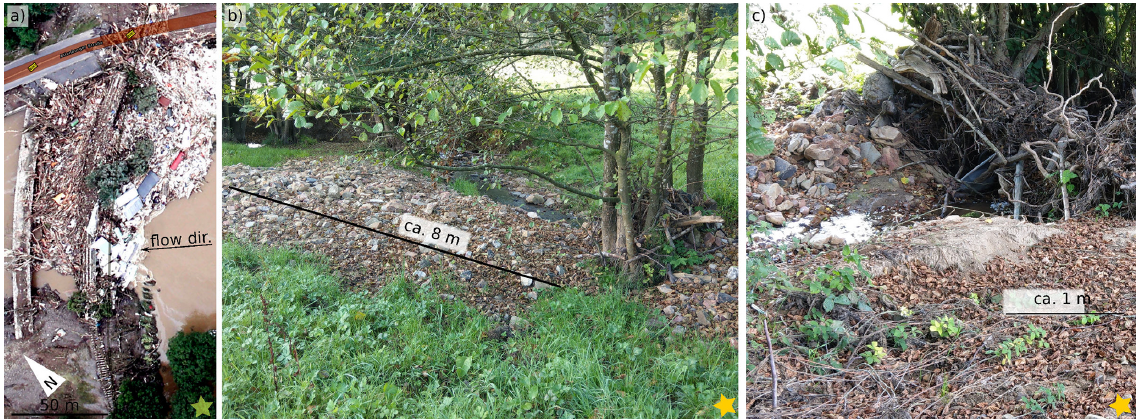
Figure 5. Effects of large woody debris. For locations on wider map see stars in Fig. 1. Pair of clogged bridges near Altenahr, bypassed along the left and right bank. Note the bipartition of the collected debris with woody material caught by the downstream road bridge and anthropogenic debris collected later by the upstream railway bridge. Note two remaining standing trees in the river depicting the width of the Ahr River before the flood. Aerial image by BBK-DLR (2022). (b) Huhnenbach near Aremberg about 2km from its source (see Fig. 1). Note clogging by woody debris at riparian trees and the resulting ejection of coarse bed material out of the channel. (c) Another clogging of the Huhnenbach some 20m upstream of panel (b) , with both ejected coarse debris and deposition of fine sediments in front of the